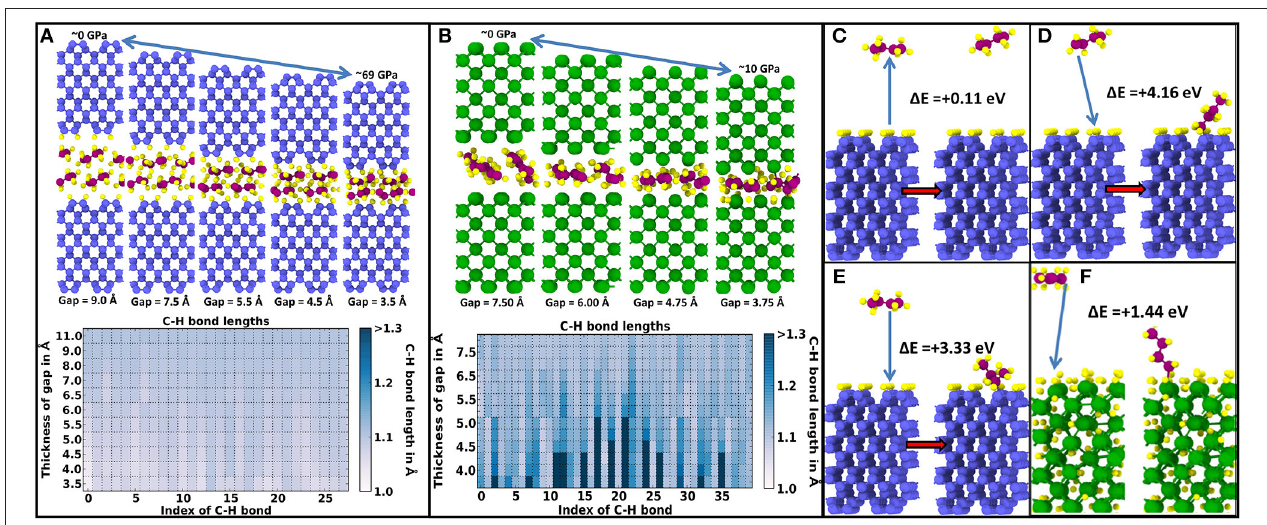
FIGURE 2 | Density functional theory (DFT) quasi-static pressure relaxation simulations showing the activation and sometimes radicalization of butane (C 4 H 10 ) molecules confined between diamond (100) and W (100) surfaces. Coloring of atoms is as follows: diamond C atoms are blue, H atoms yellow, butane C atoms purple, and W atoms green. (A) Stability of hydrocarbon C 4 H 10 molecules indicated by an almost constant C–H bond length between molecules confined between reconstructed H-passivated (100) diamond surfaces. (B) Progressive elongation and eventual breaking of some C–H bonds in the C 4 H 10 molecules with decreasing gap separation between bare W(100) surfaces. In (A) and (B) , the top panel shows selected snapshots with decreasing interface gap (i.e., increasing pressure), while the bottom panel shows the elongation of each C–H bond with decreasing interface gap. (C) Energy gain during proton transfer from a diamond (100) surface to a C 4 H 9 radical. (D) Adsorption of a CH 2 C 3 H 7 radical (with an H missing on a tail group) on a diamond (100) surface with one dangling C bond. (E) Adsorption of a CH 3 -CH–C 2 H 5 radical (with one H missing on an inner C group) on a diamond (100) surface with one dangling C bond. (F) Adsorption of a CH 2 C 3 H 7 radical (with an H missing on a tail group) on a hydrogen-saturated tungsten (100)